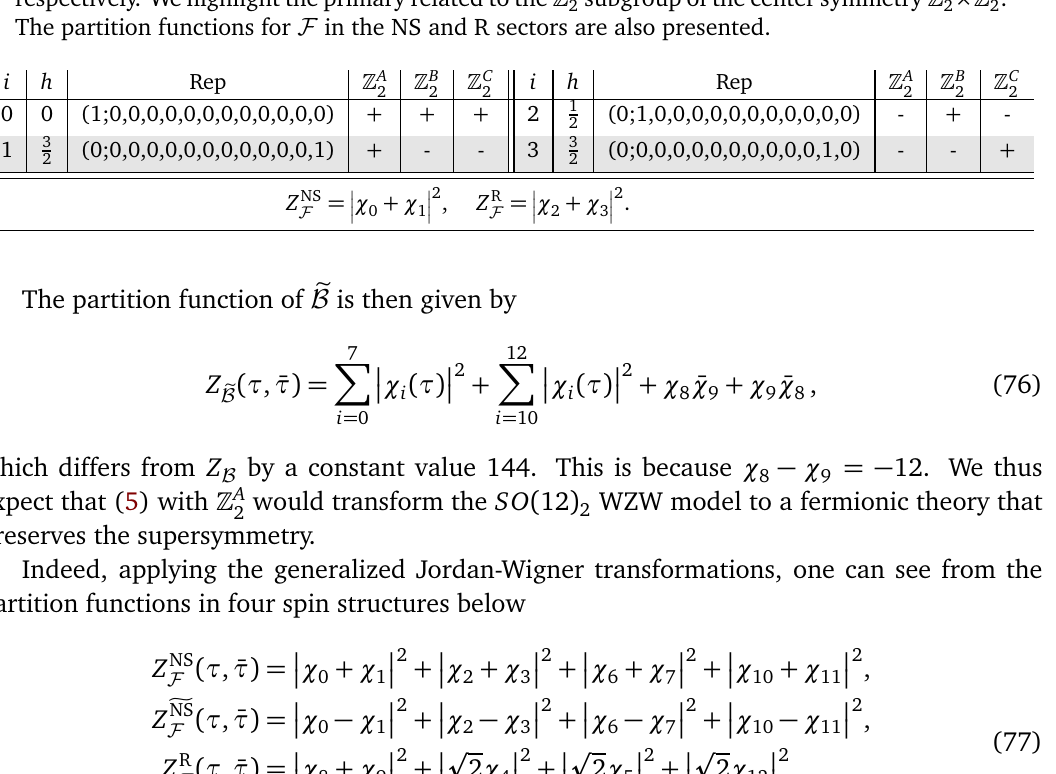
table 18. Note that the model has (cid:90) A the Verlinde lines associated with three h = 3 / 2 primaries. Gauging any of these (cid:90) would lead to essentially the same orbifold, which manifests the triality of SO ( 8 )